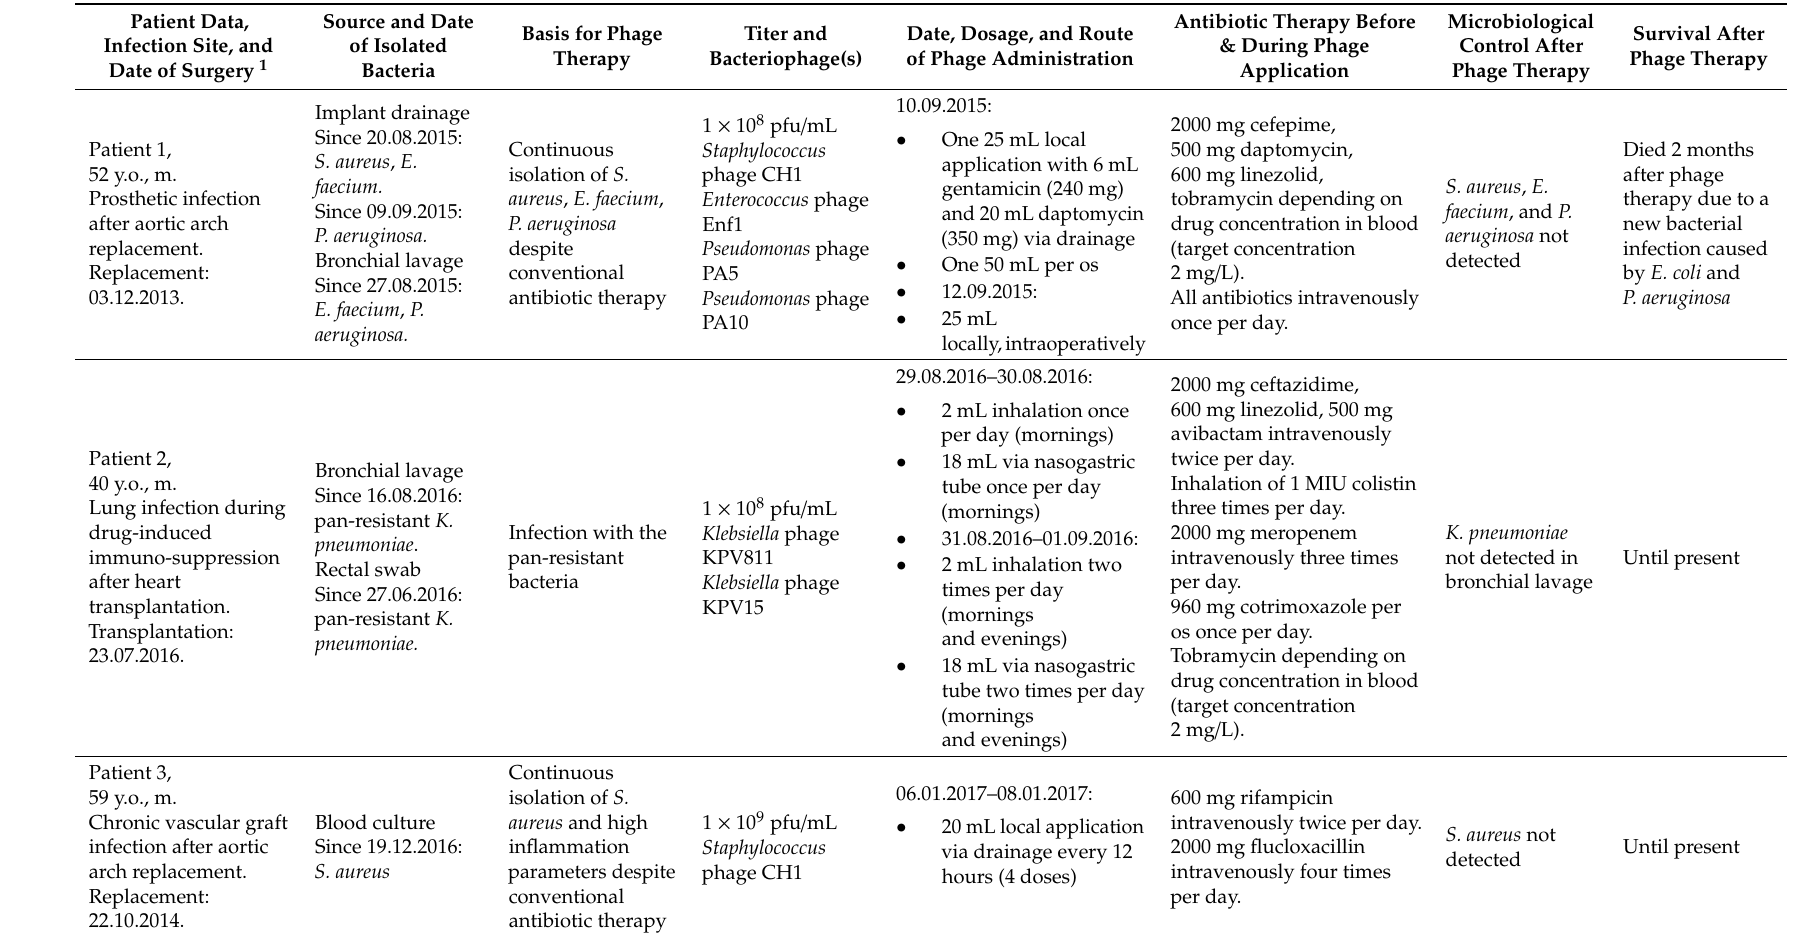
Table 1. Summary of phage therapy application and